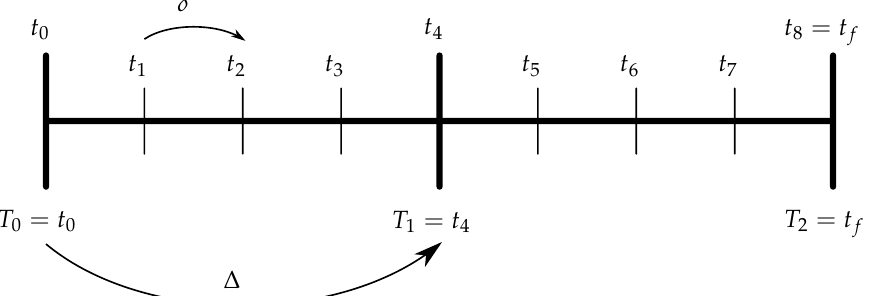
Figure 1. Visualization of the time interval [ t 0 , t f ] and notation for two different time grids. Step sizes are δ (fine grid) and ∆ (coarse grid), the coarsening factor is cf = 4. C-points (F-points) are drawn as long (short) vertical lines which define the time grids Θ ∆ ( Θ δ